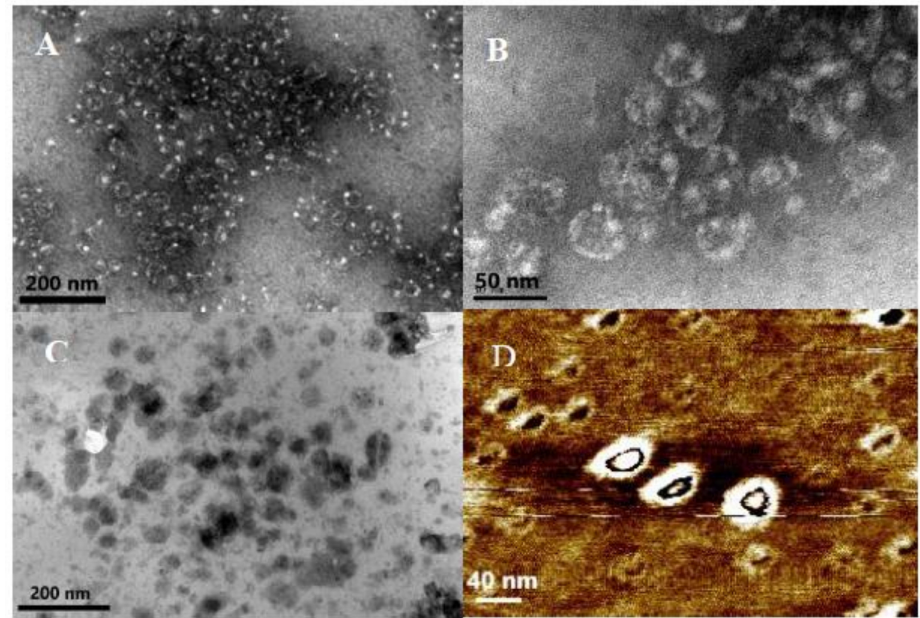
Figure 1. TEM images of nanocapsules prepared using PDMAEMA-b-PS as stabilizers with various phase fraction (( A , B ): contained water phase 13 wt % to total weight; ( C ): contained water phase 23 wt % to total weight) dispersed in methanol and stained by phosphotungstic acid (2%) and height image of tapping mode AFM (( D ): contained water phase 13 wt % to total